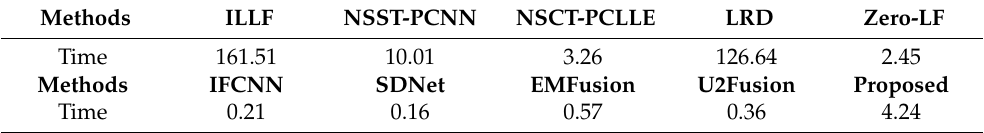
Table 5. Running times of different methods for fusing two source images of 256 × 256 pixels each.